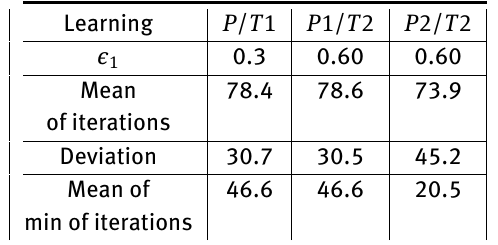
Table 3: Results of testing on 106